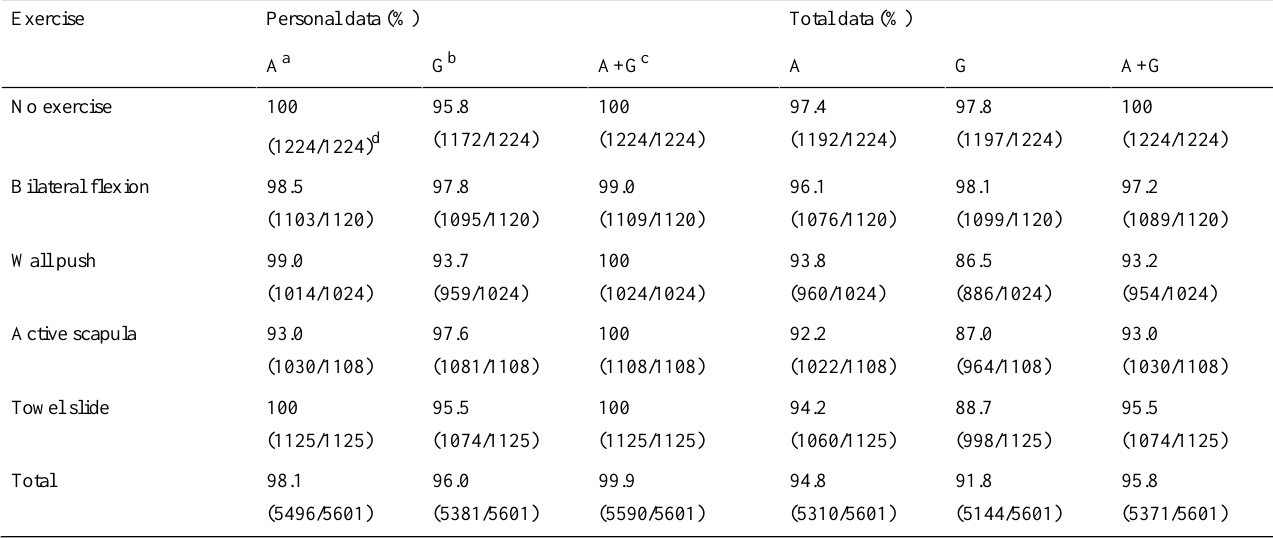
Table 1. Accuracy of the convolutional neural network model according to